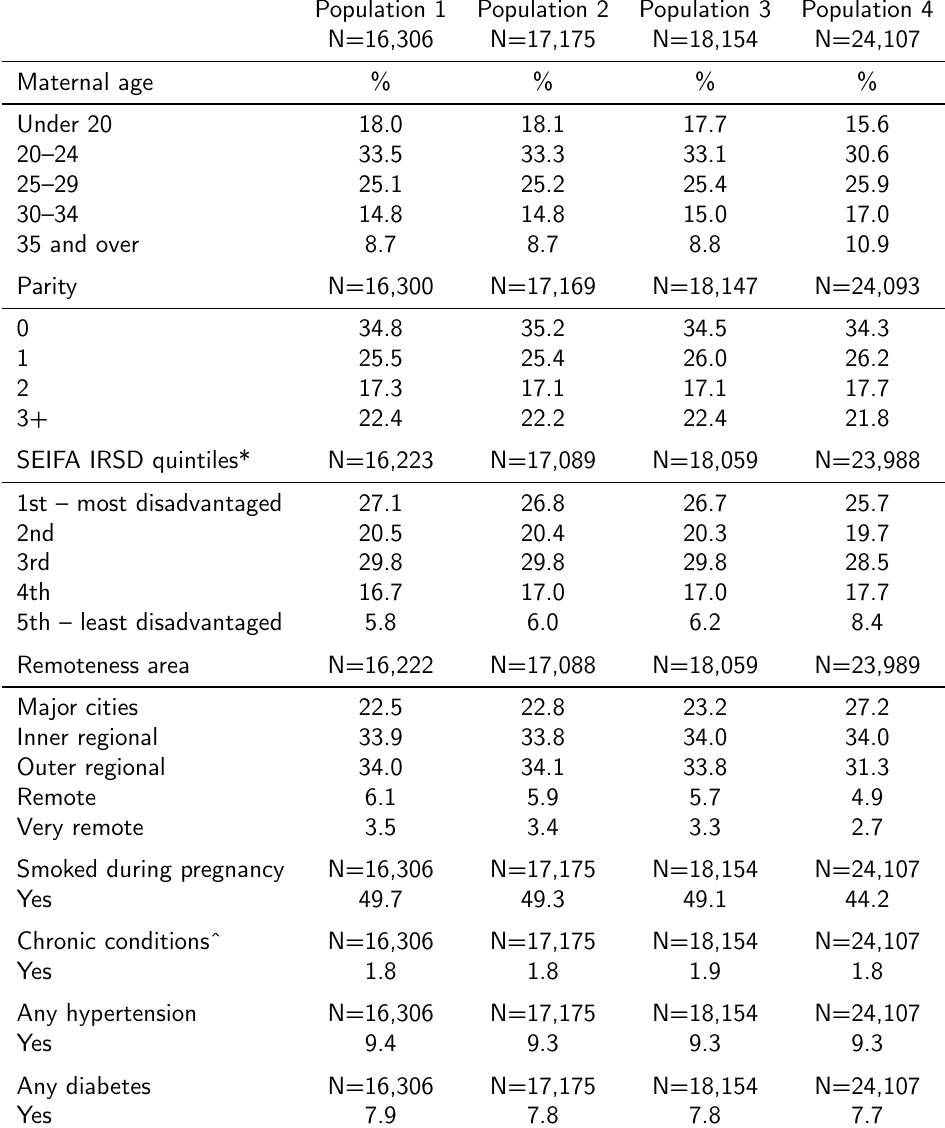
Table 3: Demographics at the time of birth of all Aboriginal or Torres Strait Islander mothers who gave birth to at least one singleton baby in NSW between 2010 and 2014 by method of reporting of